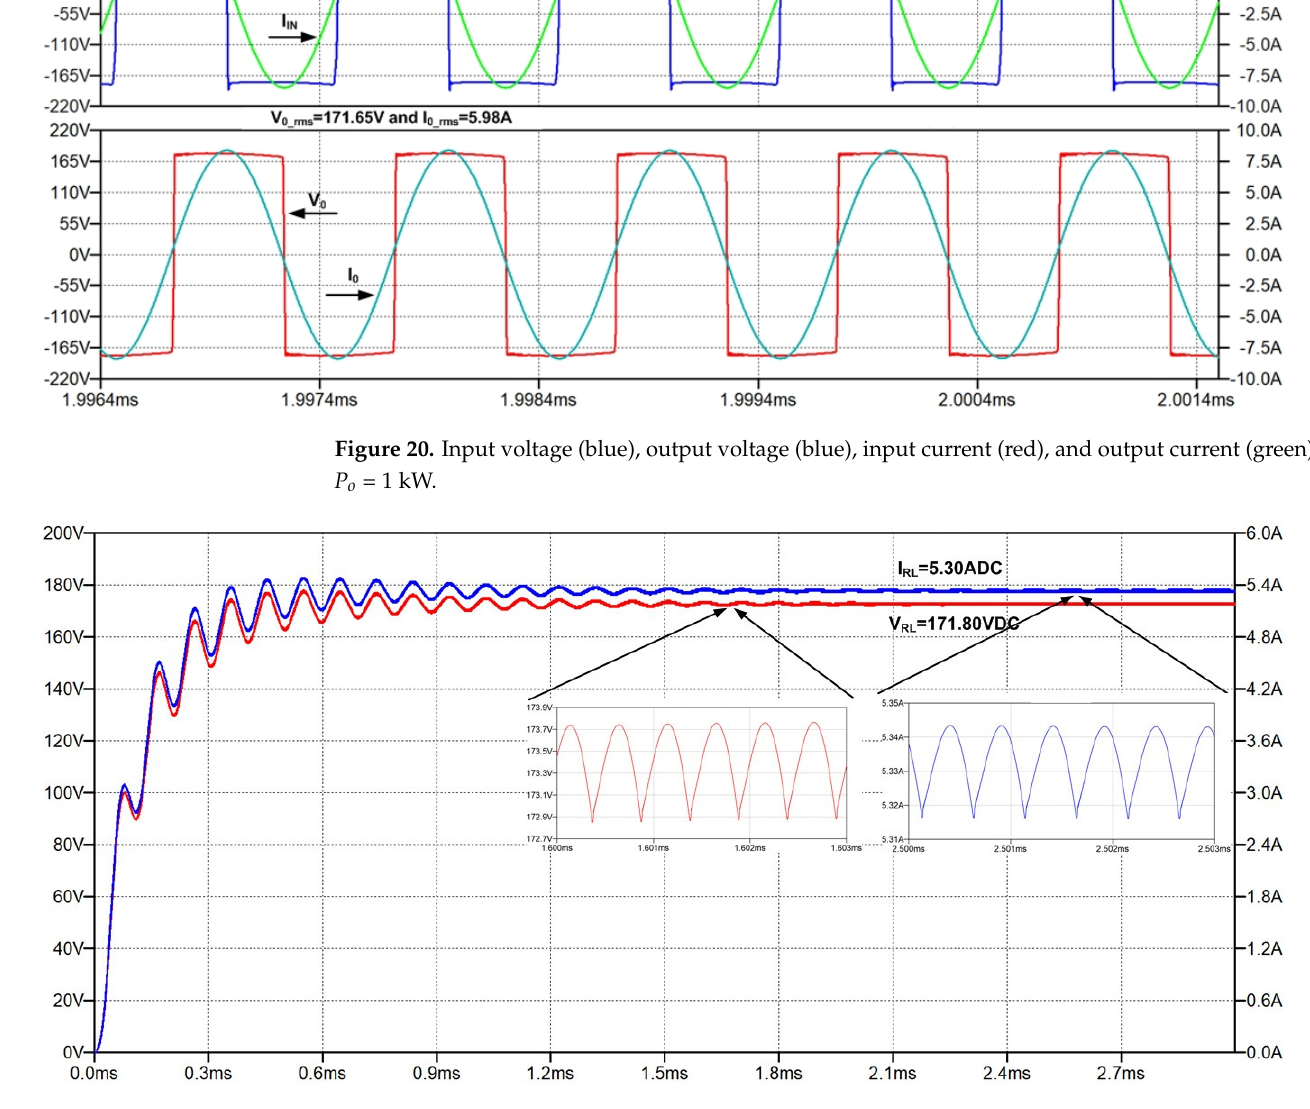
Figure 21. Voltage V RL =171.80VDC (red) and current I RL =5.30ADC (blue) waveforms at the load.